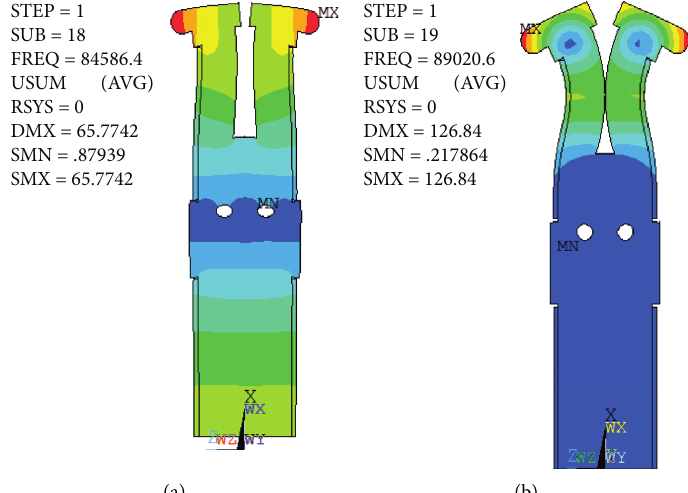
Figure 7: Unconstrained stator mode. (a) Global first-order longitudinal vibration mode. (b) Partial second-order bending vibration mode.